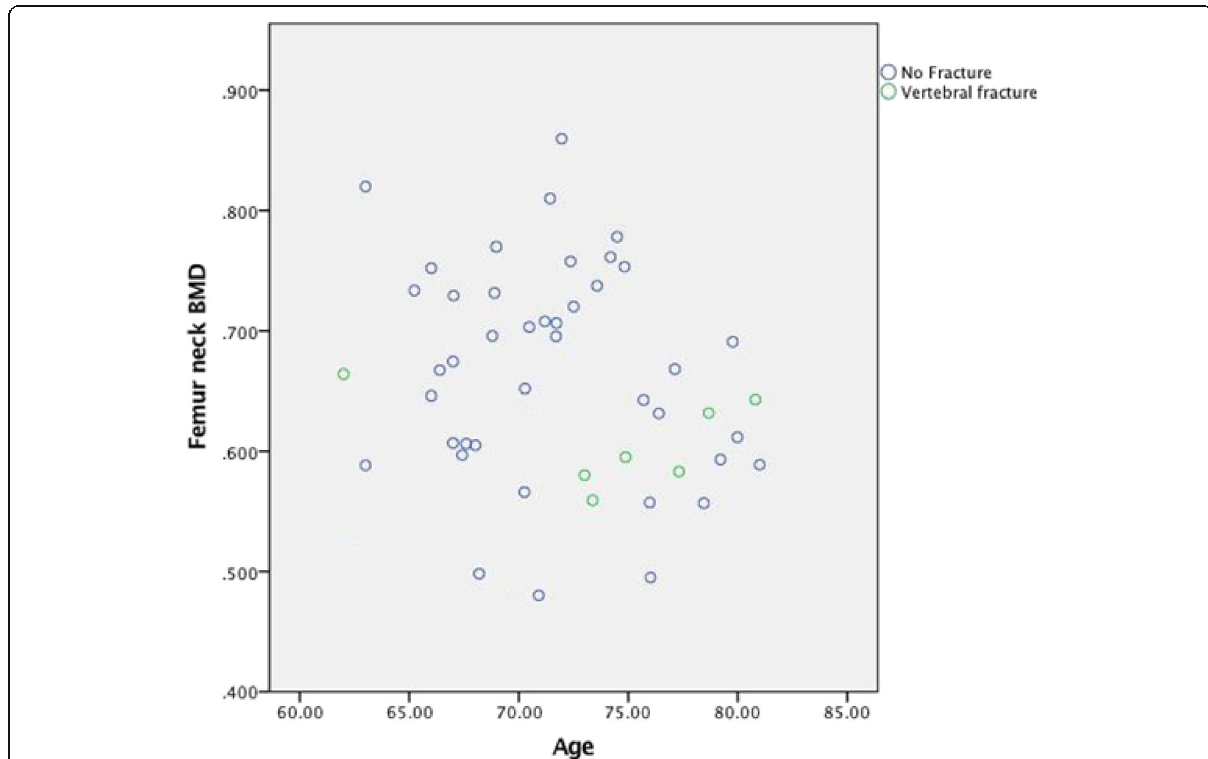
Fig. 2 Age to baseline femoral neck BMD relation